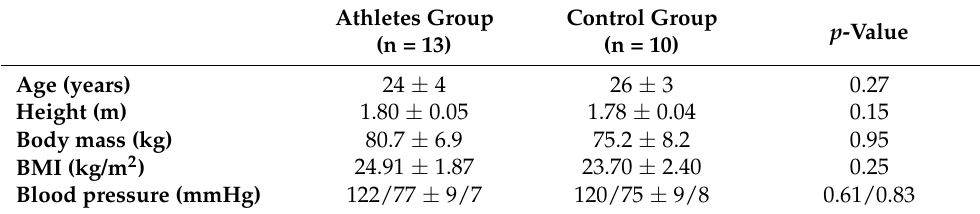
Table 1. Mean ± standard deviation of characteristics of